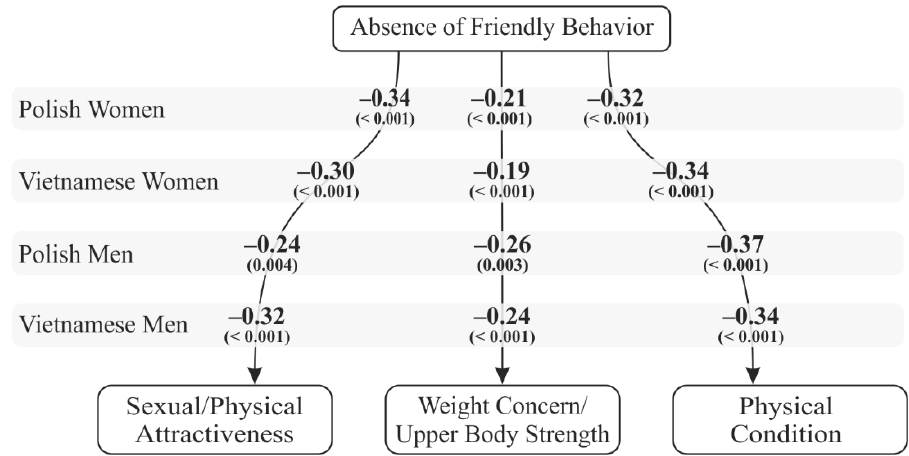
Figure 3. Absence of friendly behavior as a predictor of body esteem.